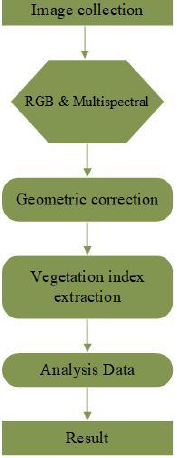
Figure 1. Study area